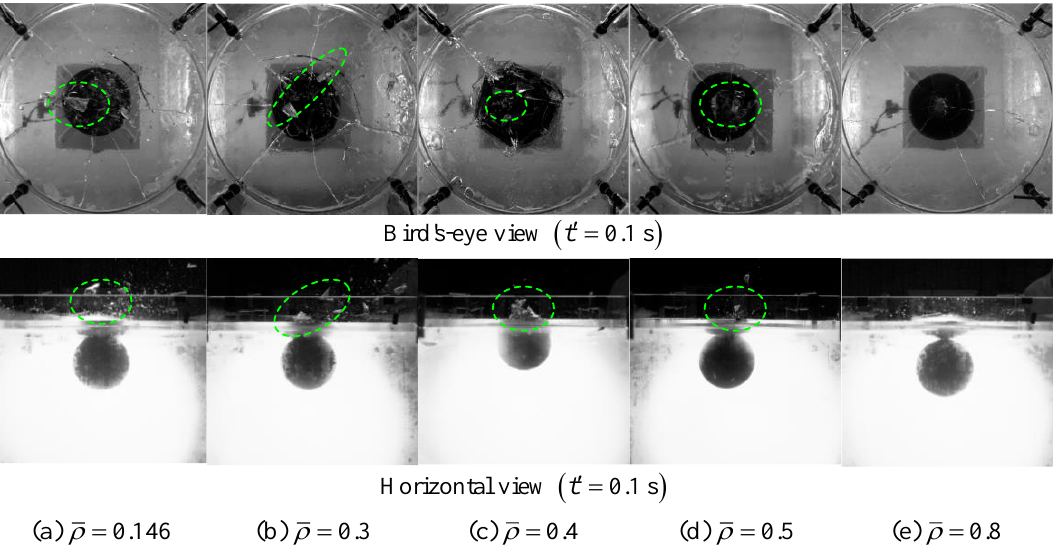
Figure 16. Destructiveness of ice plates caused by different relative densities of spheres ρ , as denoted in the subfigures, from different views.